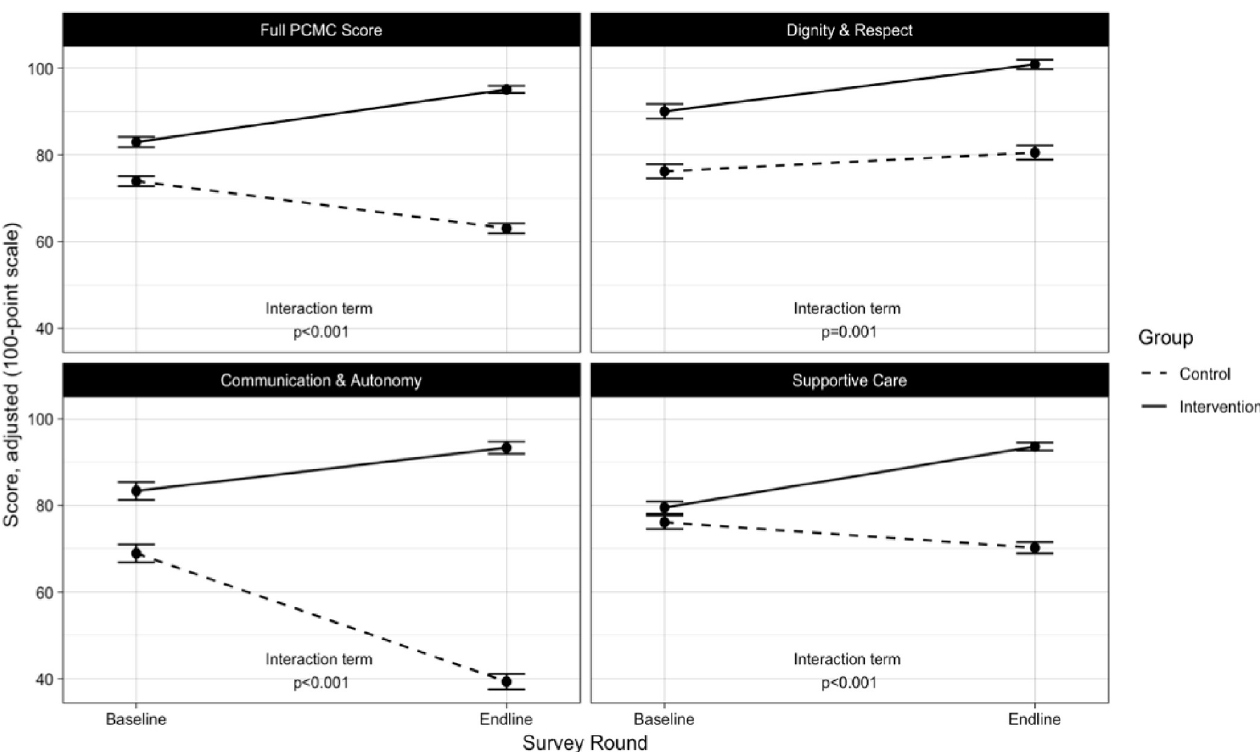
Fig 1. Impact of intervention on total PCMC score and subdomains. � All estimates adjusted for age, parity, education, wealth, caste, facility type, delivery provider, ANC visits, and pregnancy complications. Robust standard errors were used.